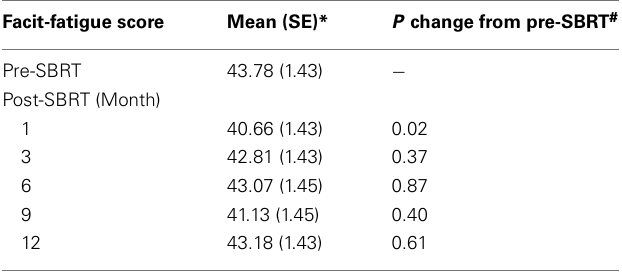
Table 3 |Age-adjusted pre- and post-SBRT fatigue